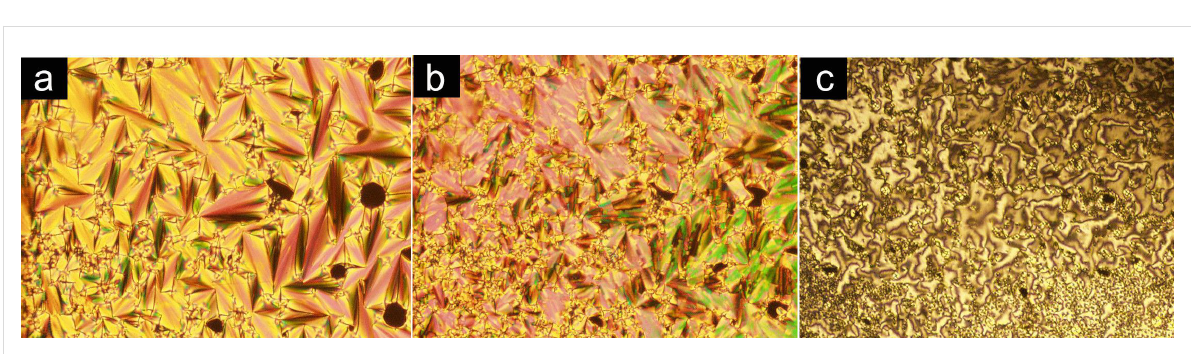
Figure 2: Optical textures observed on POM of amide 19 . (a) Fan-shaped focal conic texture of the SmA mesophase upon cooling at 201 °C; (b) and (c) broken fan-shaped focal conic and schlieren textures of the SmC mesophase upon cooling at 198 °C.